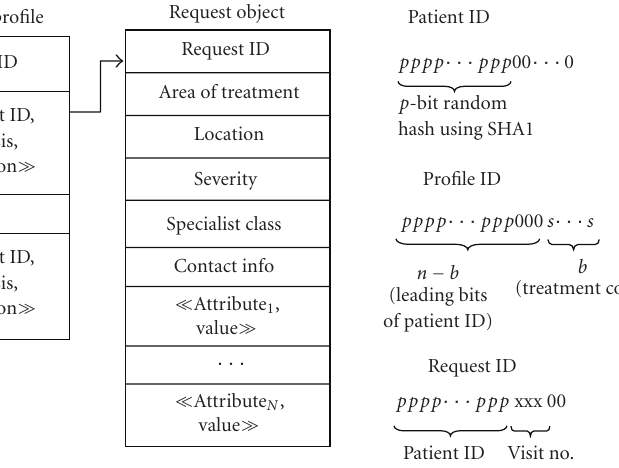
Figure 4: Structure of patient and treatment profiles, request object.